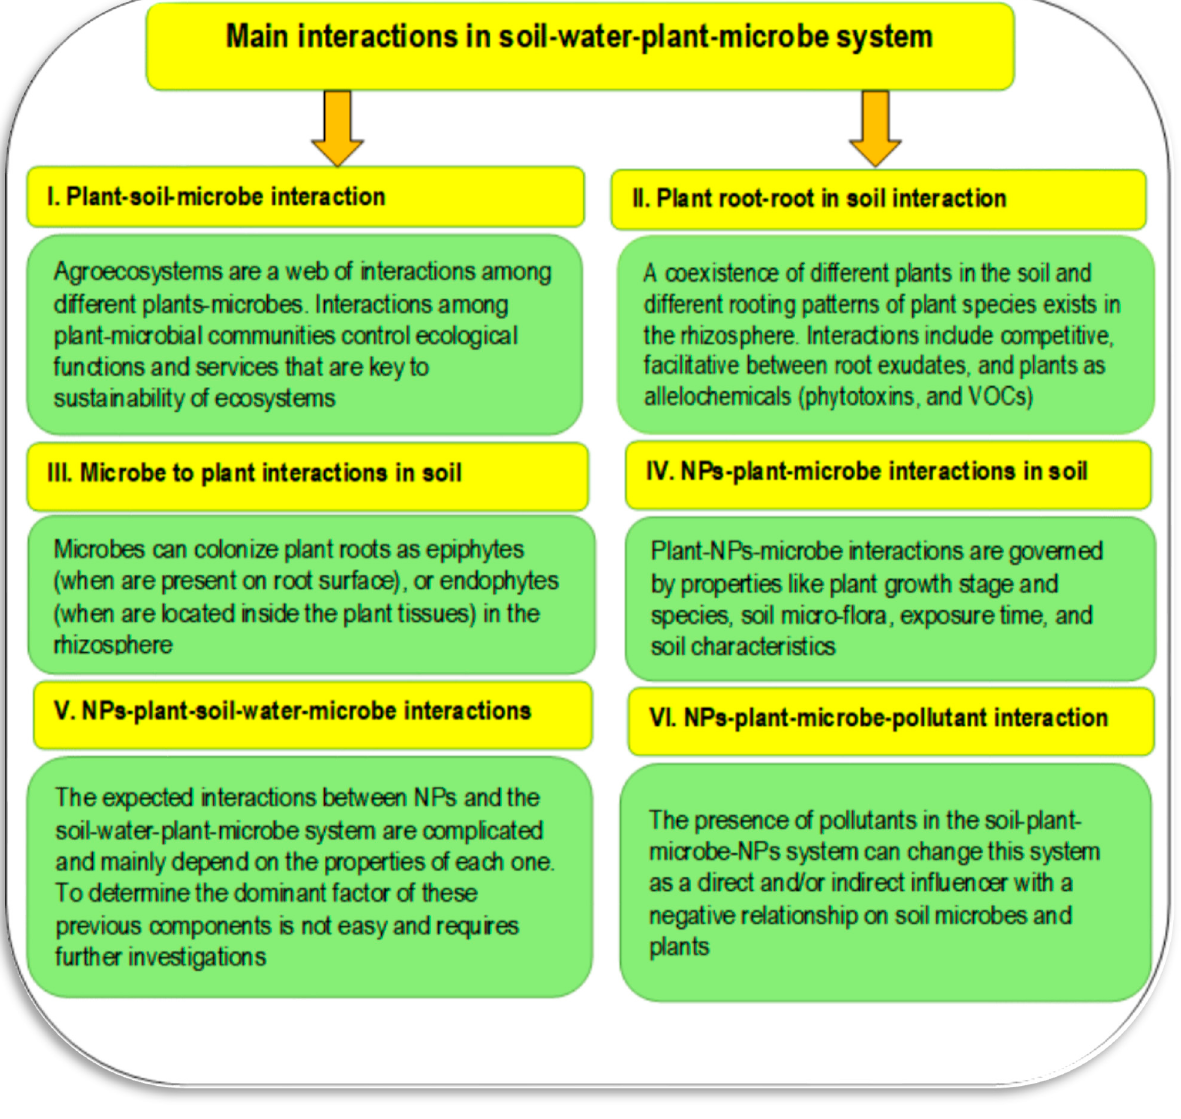
Figure 15. The possible interactions that can happen in the soil–water–plant–microbe system. Sources : [39,46,119]). Abbreviation : Volatile organic compounds (VOCs).